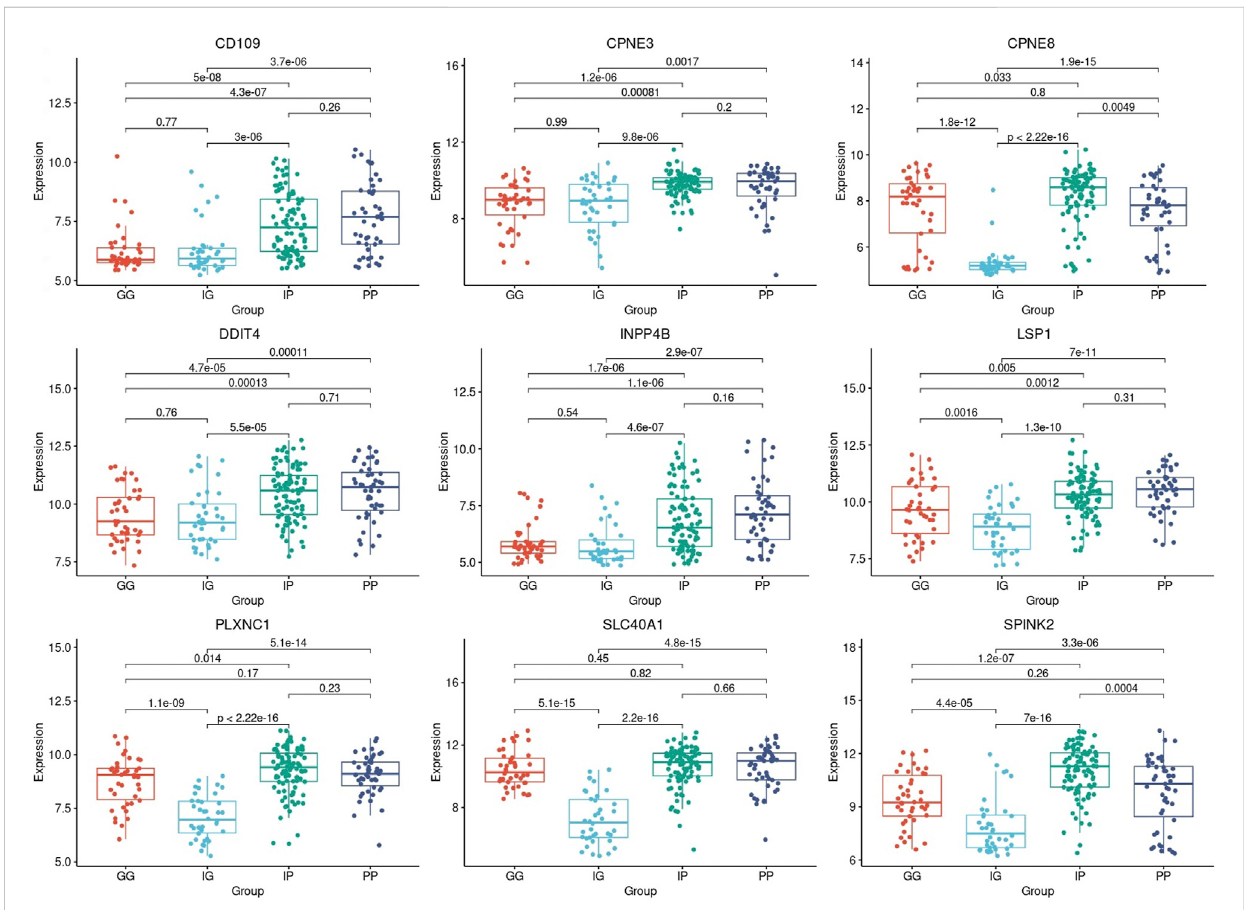
FIGURE 6 Boxplots based on risk subcategories of the nine prognostic genes in AML patients. A boxplot was constructed with the gene expression pro fi le of eachprognosticgeneinallthesamplesthatwerecategorizedintotheGood-Good(GG),Intermediate-Good(IG),Intermediate-Poor(IP),andPoor-Poor (PP) risk